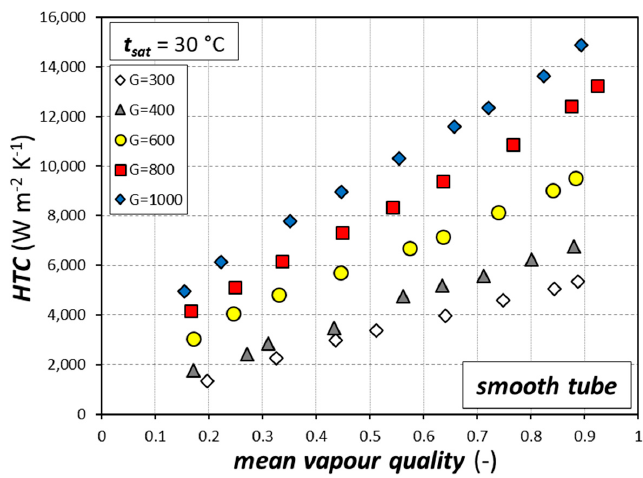
Figure 5. Heat transfer coe ffi cient during condensation for the smooth tube vs. mean vapor quality at t sat = 30 ◦ C. G expressed in [kg m − 2 s − 1